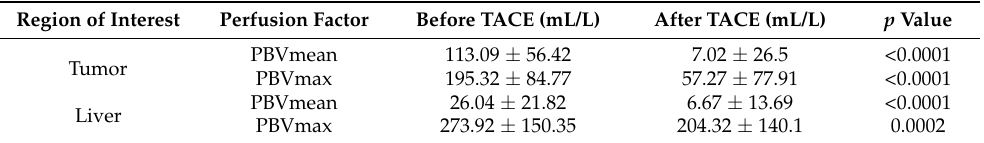
Table 6. Quantitative analysis of perfusion parameters of the tumor and liver, measured on axial images of cone-beam CT-based perfusion mapping, showing the maximum diameter of the tumor before and after transarterial chemoembolization for hepatocellular